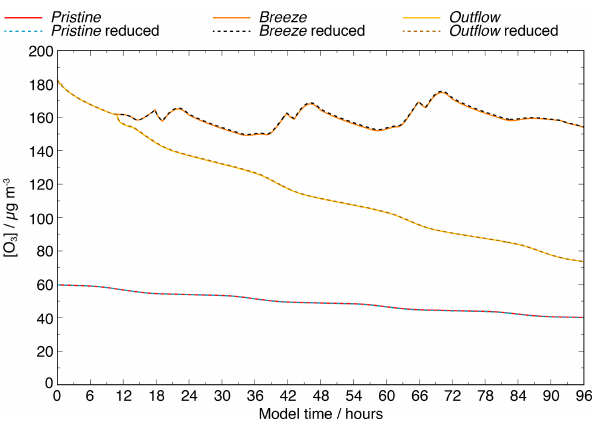
Figure 1. Modelled concentrations of ozone within the pristine , breeze , and outflow scenarios compared between the simulations with the full (solid lines) and reduced (dotted lines) CAPRAM- DM1.0 and CAPRAM-HM3.0